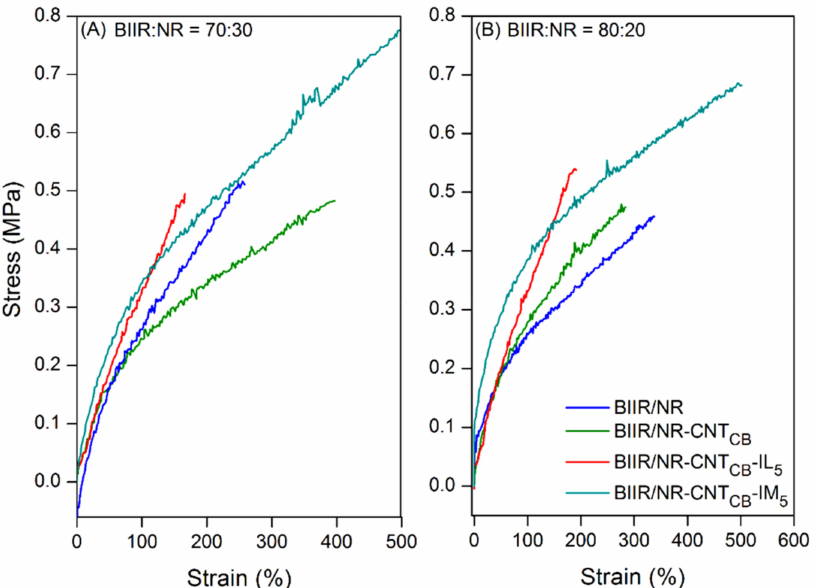
Figure 9. Stress–strain curves of pure rubbers and their composites with and without IL and IM modifiers, BIIR:NR ratios of 70:30 ( A ) and 80:20 ( B ) after healing propagation. Table 4. Mechanical properties of the pure rubbers and their composites after self-healing propagation.